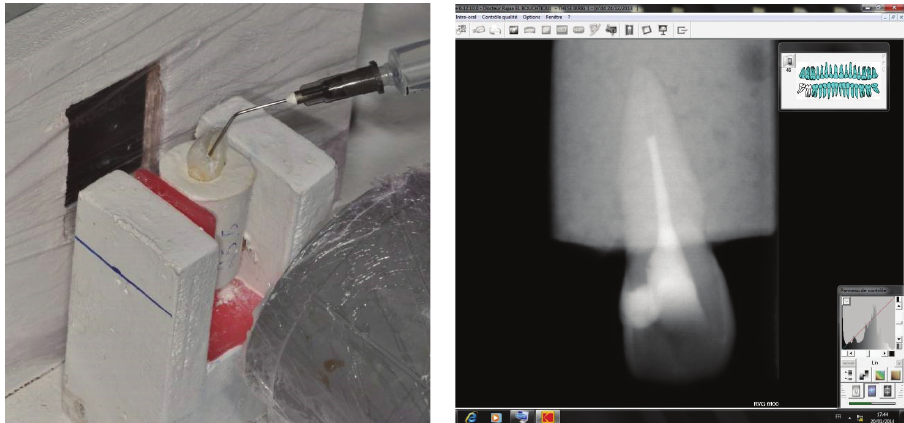
Figure 3: Passive irrigation with conventional needle and the corresponding radiograph.